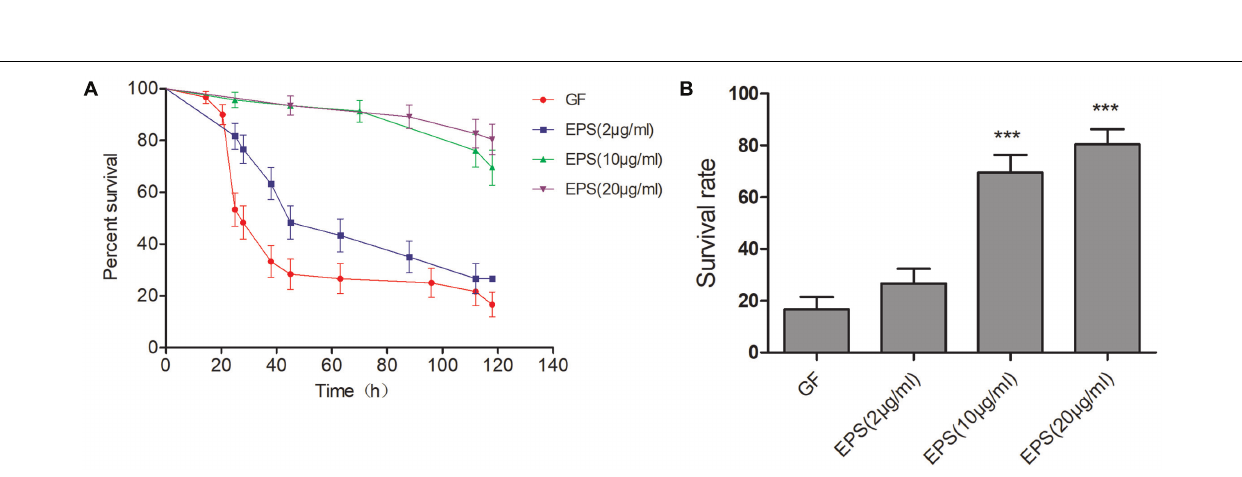
Frontiers in Microbiology |